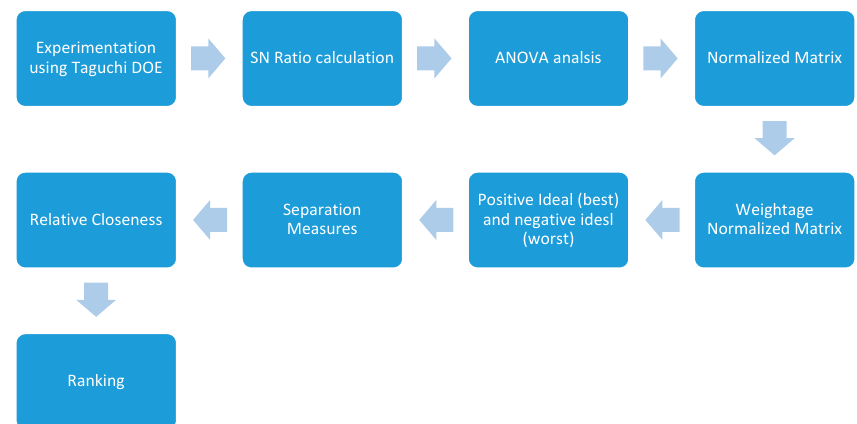
Figure 7. Process flow chart of implementation of TOPSIS for Multi-attribute optimization of process parameters.